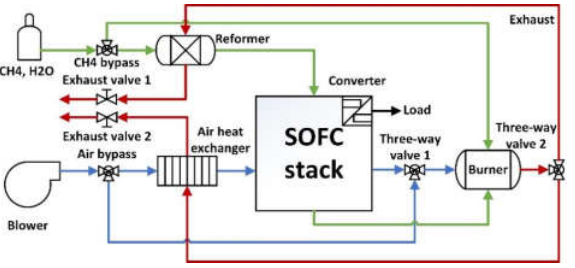
Figure 1. System structure and operating principle of kW-class SR-SOFC [28].